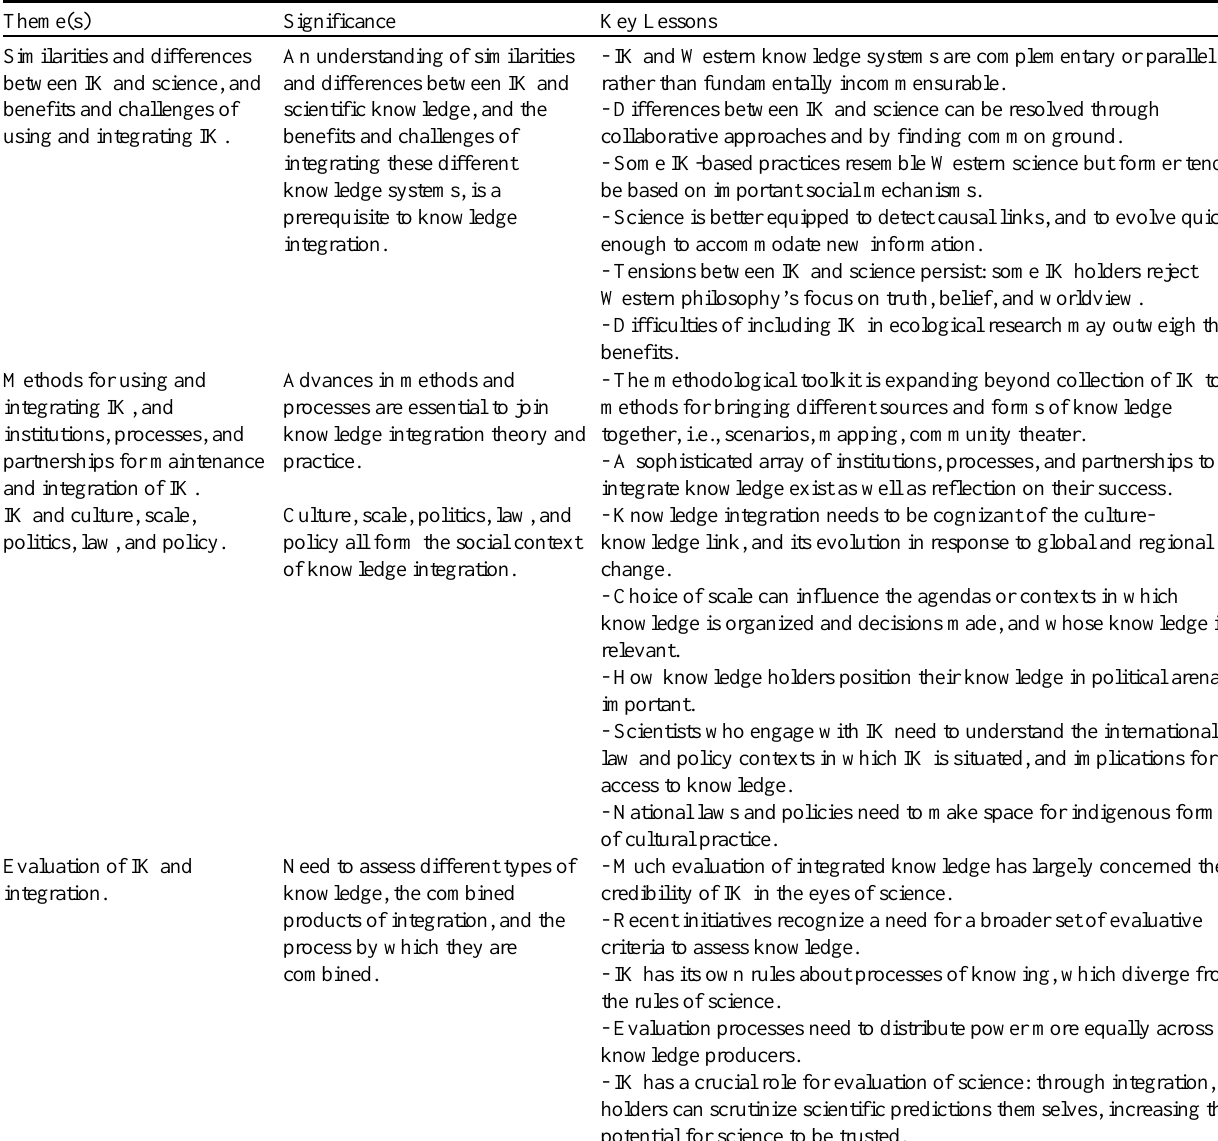
Table 2. Summarized themes, their significance for knowledge integration, and key lessons identified in reviewed literature. Introductions and synthesis chapter of Reid et al. (2006) were excluded from analysis. IK = indigenous